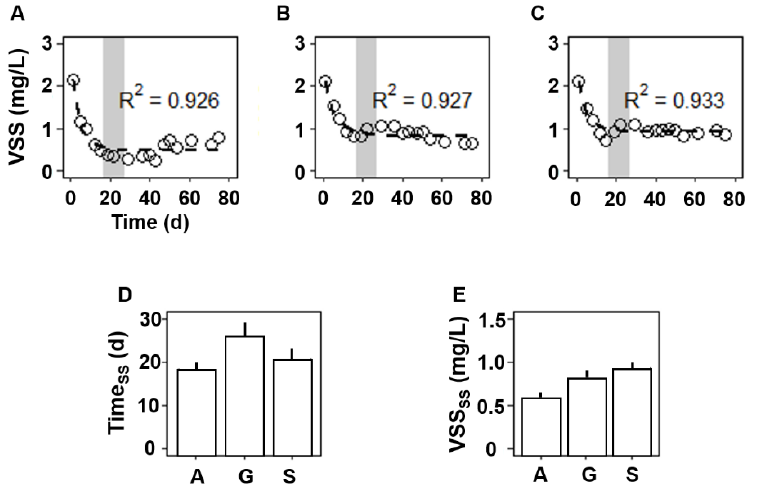
Figure 1. Dynamic functional acclimation during reactor startups. VSS concentrations (open circles) in the A ( A ), G ( B ), and S ( C ) reactors are shown over time. Dotted lines indicate the model predictions. The time periods (Time ss ) taken to reach the steady state of VSS ( D ) and the VSS (VSS SS ) levels at the steady state ( E ) were estimated using the model predictions. The range of the Time ss measured with the three carbon sources are shown with shaded areas in ( A – C ).